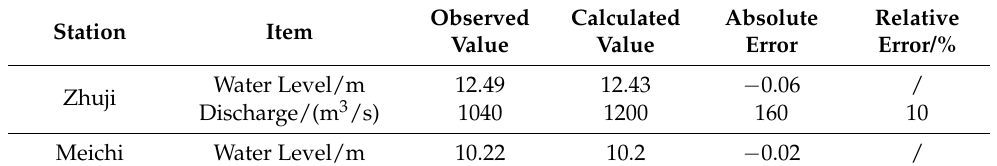
Table 6. Simulation results of the 1D hydrodynamic model for the historical flood No.20110613.